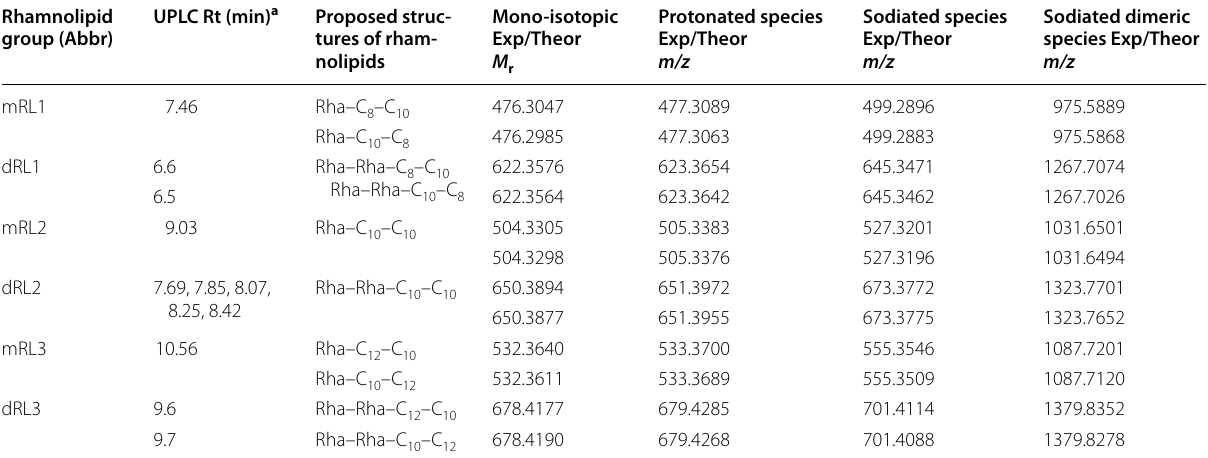
Table 3 Summary of the rhamnolipids extracted from cultures of P. aeruginosa ST5, as detected with high resolution